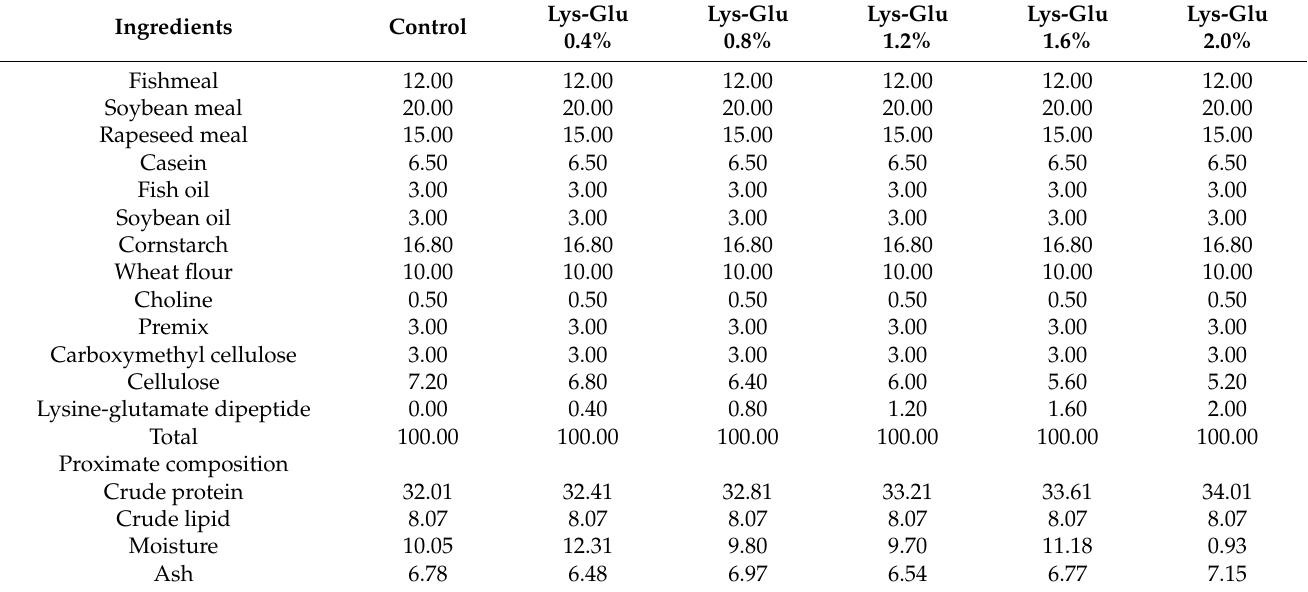
Table 3. Diet formulation and chemical composition of the Lys-Glu dipeptide diet (% dry matter).